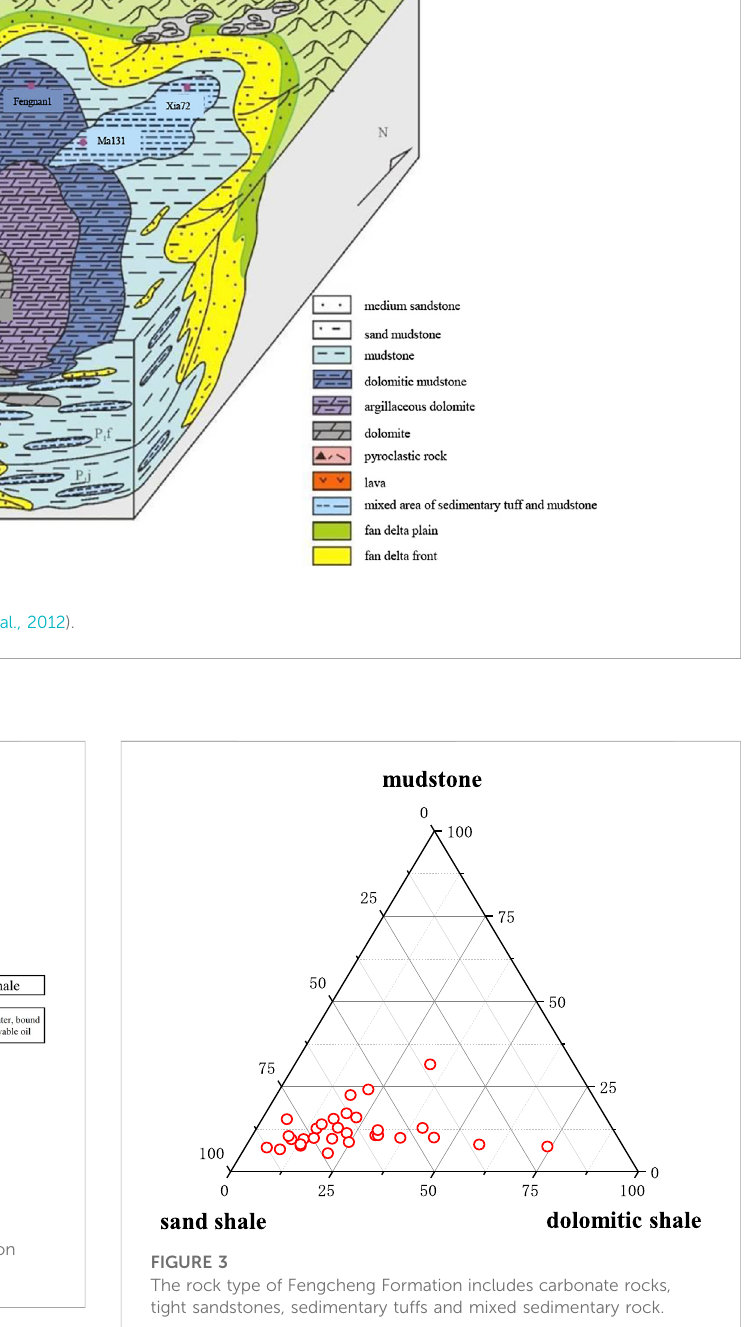
(dolomite and calcite) ranges from 8.5% to 70.9%, with an average of 22.89%. Clay minerals content is low which ranges from 5.4% to 24.1%, with an average value of 11.85%. The main clay minerals types are montmorillonite, mixed layer, montmorillonite mixed layer and illite. Montmorillonite content is 5% ~ 88%, with an average of 31.8%. Illite montmorillonite mixed layer is